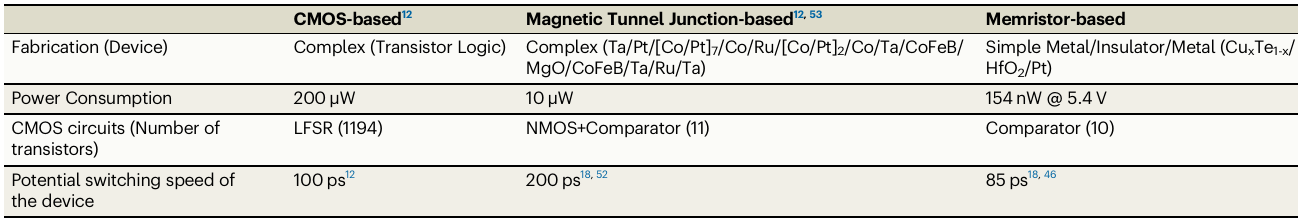
Table 2 | Comparison between various probabilistic computing hardwares CMOS-based 12 Magnetic Tunnel Junction-based 12,53 Memristor-based Fabrication